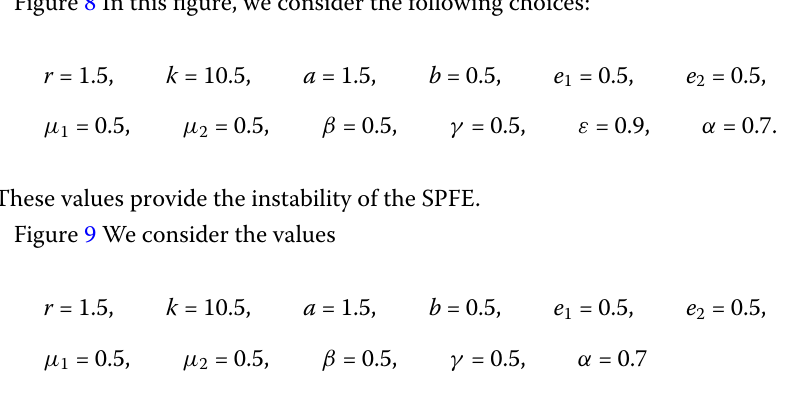
These values provide the instability of the